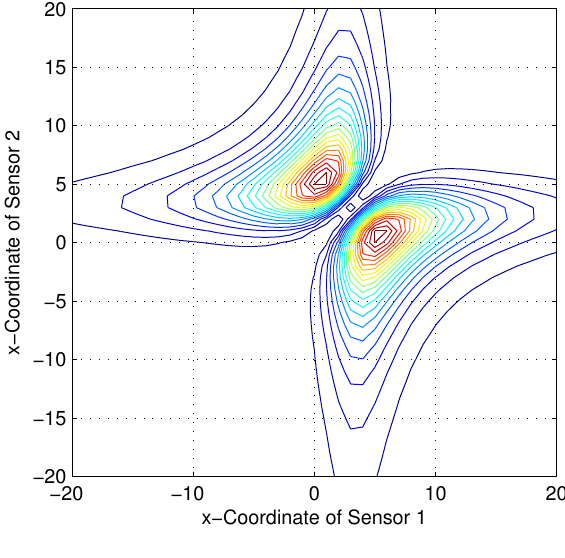
Figure 6. Variation of Fisher information determinant value with the AoA sensors positions (Contour